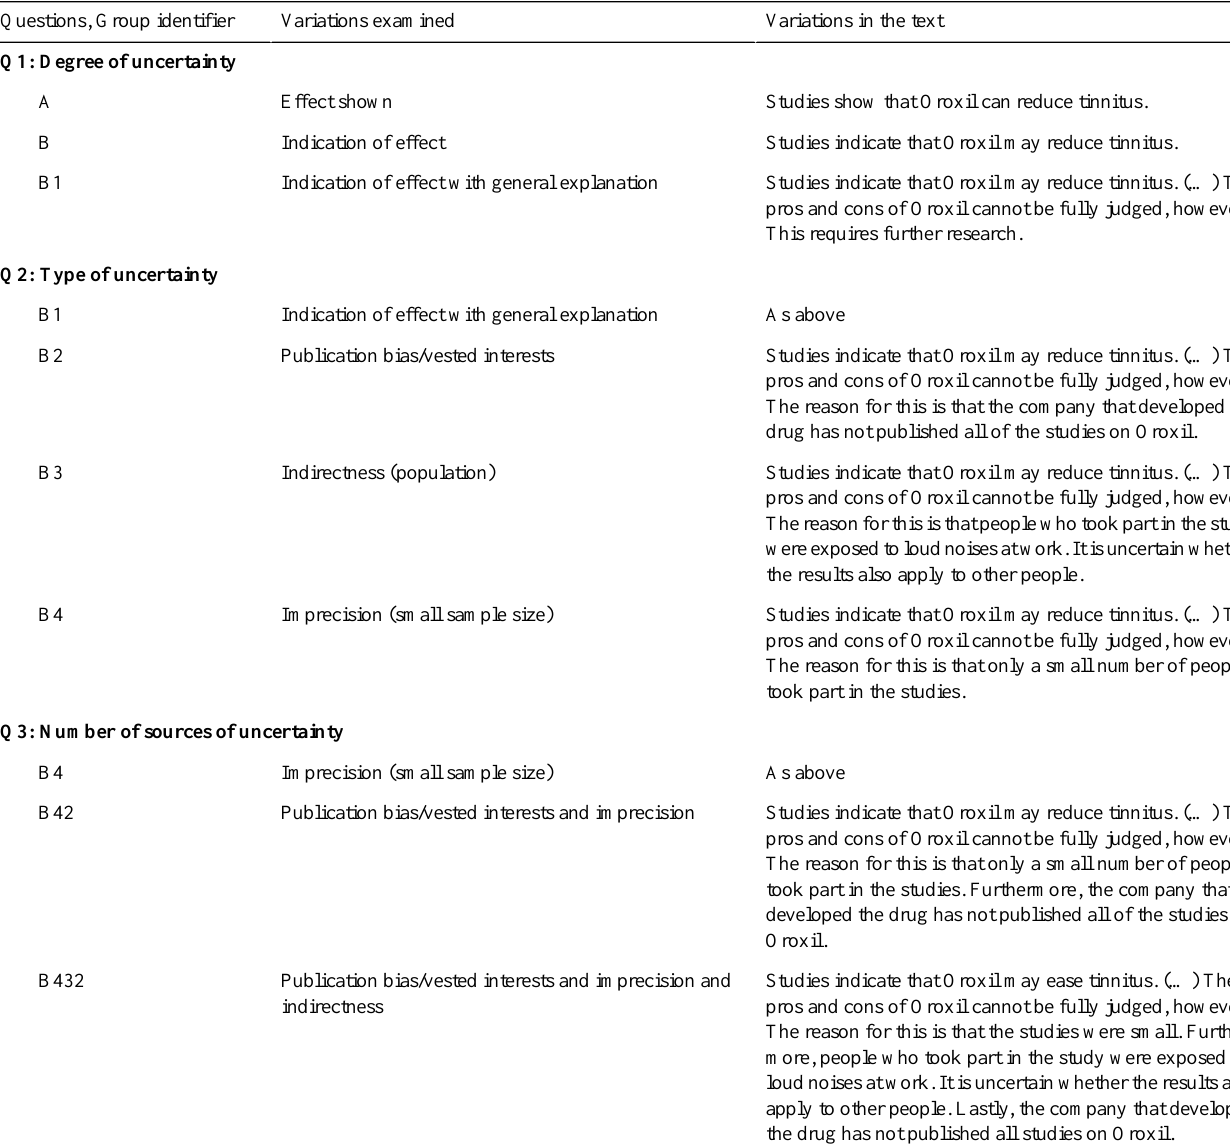
Table 1. Variations of the research summaries used to examine the 3 overarching research questions (translated from German).